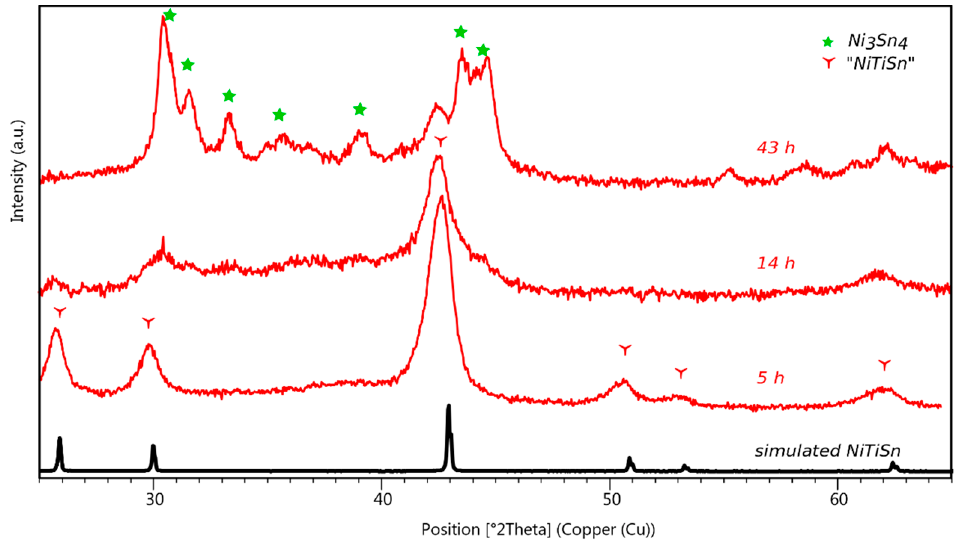
Figure 4. XRD patterns for samples mechanically alloyed at 700 rpm during 5, 14, or 43 h.